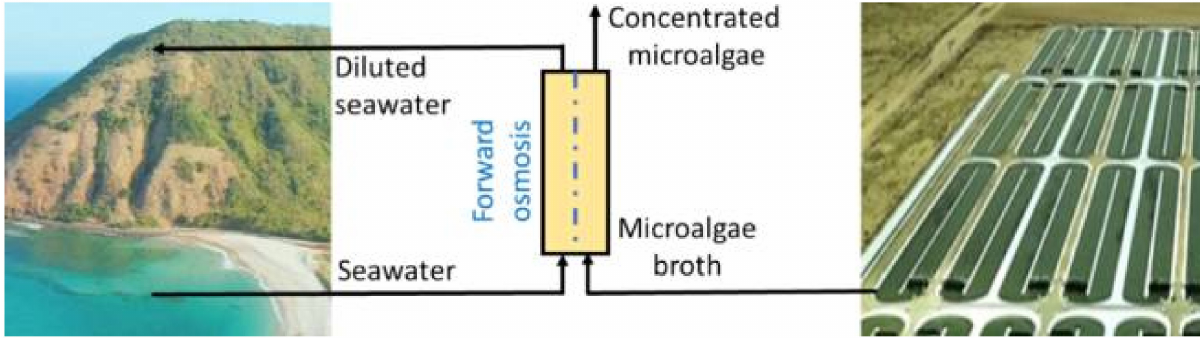
Figure 5. Schematic representation of forward osmosis process using seawater draw solution for the dewatering of fresh water microalgae. Reprinted with permission from Nawi et al. [88], Copyright 2020, with permission from